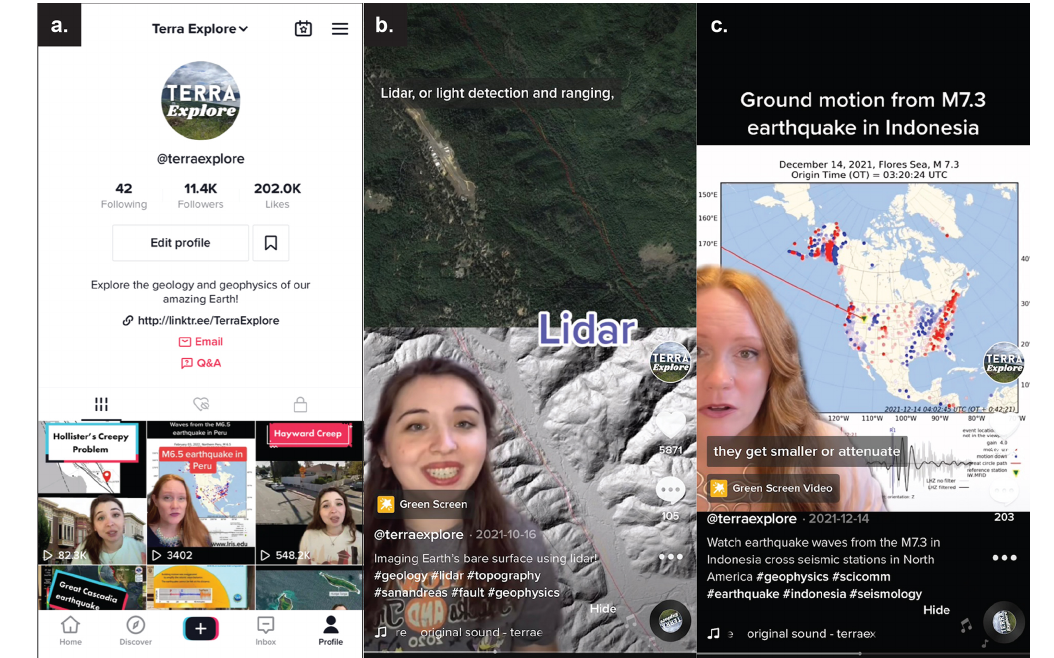
Figure 1. (a) Representative screenshot of the Terra Explore account. Our profile page has a Linktree that provides external links to the UNAVCO, IRIS, and OpenTopography websites. (b) Screenshot of typical video using the “green screen” effect. (c) Example screenshot of a GMV